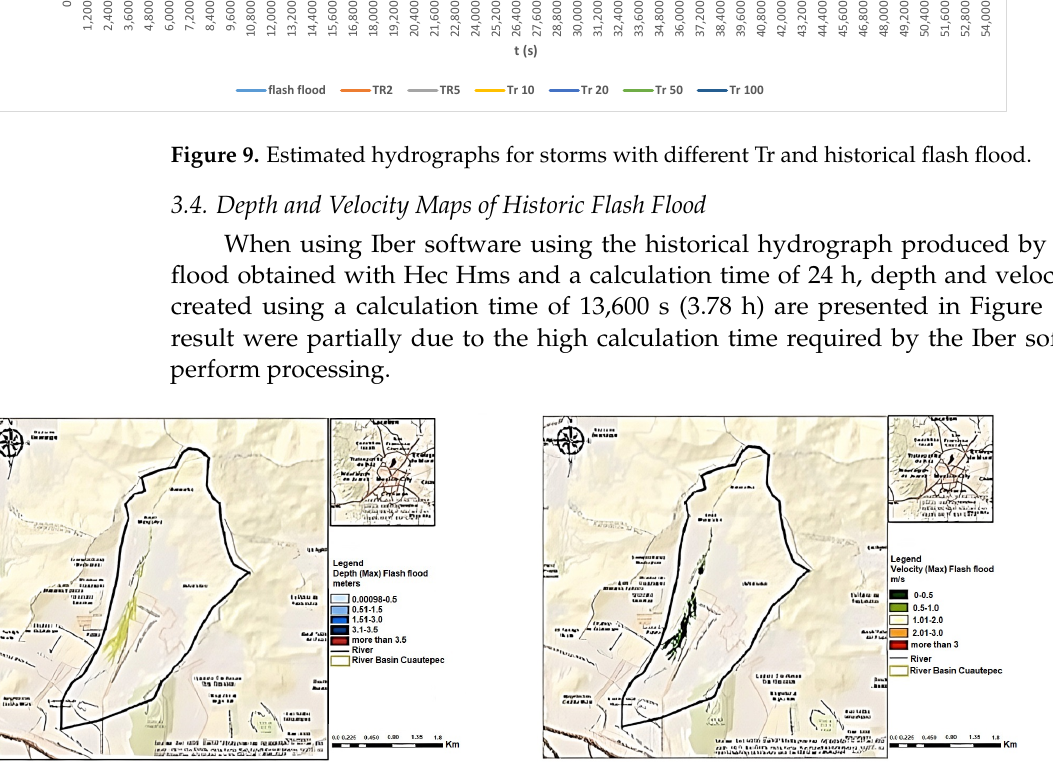
Figure 10. Depths and velocity maps, historical flash flood using Iber t = 13,600 s (3.78 h).